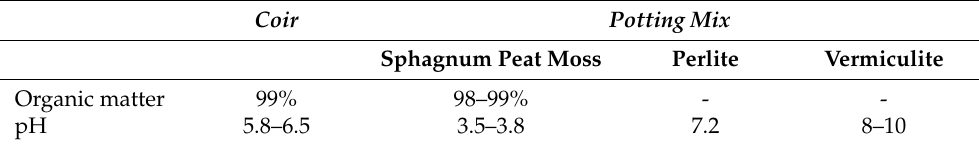
Table A1. Organic matter and pH for coir and potting mix components. Coir Potting Mix